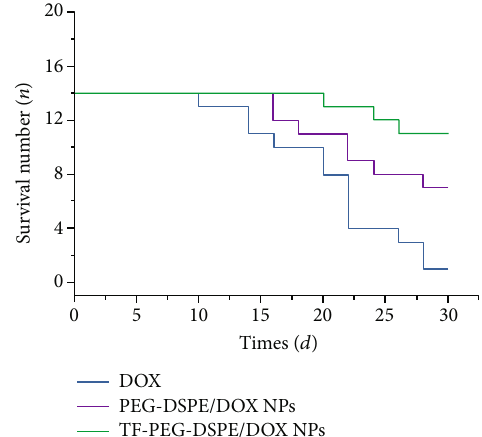
DOX PEG-DSPE/DOX NPs Figure 8: Survival records of mice in each